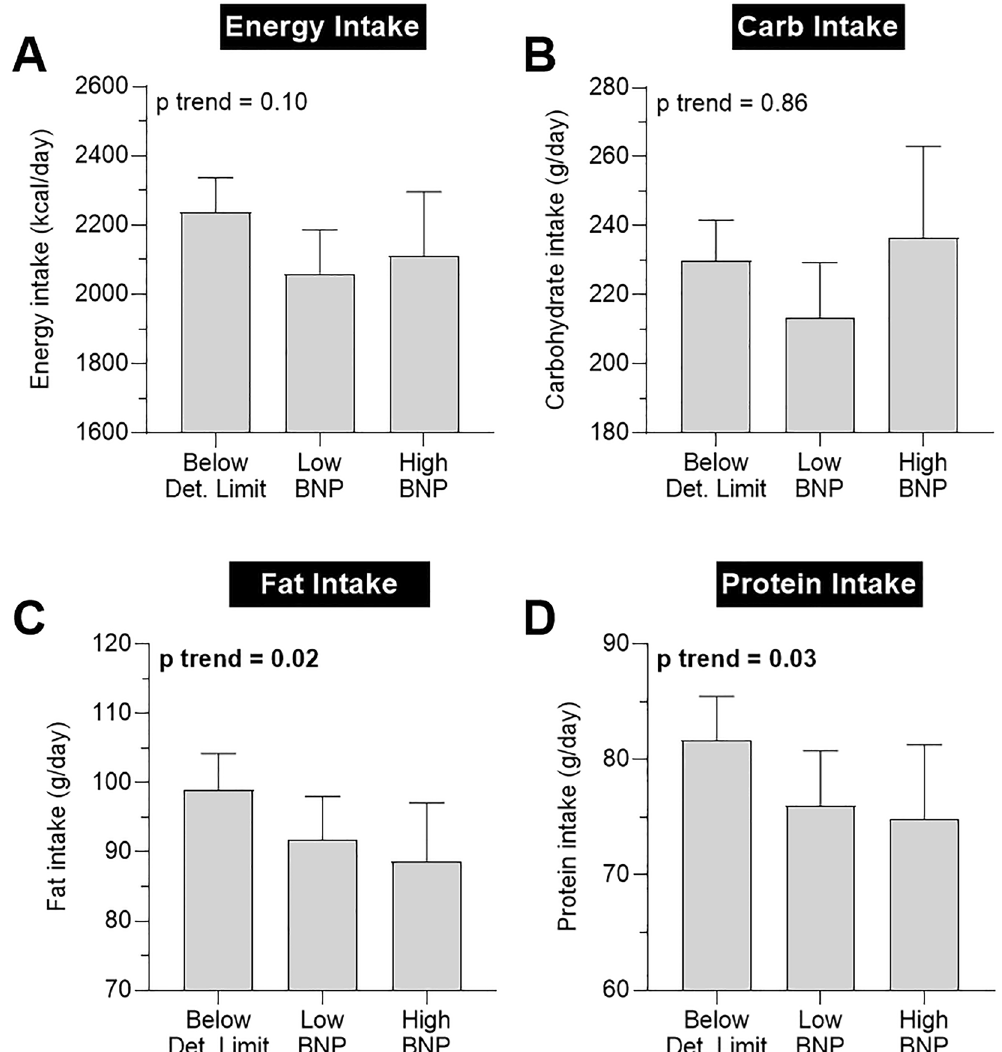
Figure 4. Associations between NT-proBNP concentration and total energy and macronutrient intake. Association between NT-proBNP concentration and ( A ) energy intake, ( B ) carbohydrate intake, ( C ) fat intake, and ( D ) protein intake. Information about the nutritional intake was assessed by a self-reported 12-month nutritional, retrospective (food frequency) questionnaire. Bars denote mean and error bars denote 95% CI of the mean. P trend analyses were performed using a linear regression model with NT-proBNP group as ordinal covariate and the variable of interest as dependent variable. Definition of NT-proBNP groups is shown in Fig. 2. CI; confidence interval; NT-proBNP, N-terminal pro brain natriuretic